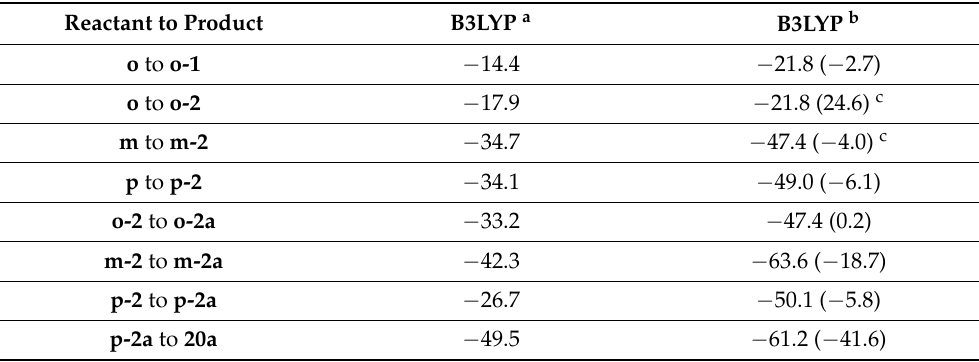
Figure 1. Relative free energies (kcal.mol − 1 ) of the individual stationary points on the potential energy surface (PES) of the formation of o-2 (see Tables 1 and S1 and the Section 3 for details). Table 1. Free energies (kcal.mol − 1 ) of the experimentally inferred products (characterized by ab initio/GIAO/NMR and X ‐ ray di ff raction structural tools [14]) relative to 1,2 ‐ C 2 B 8 H 10 (o) + one or two NHC(s).